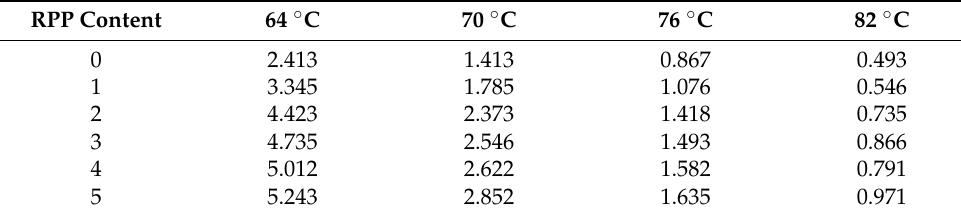
Table 5. Influence of temperature and RPP content on the G*/sin δ (kPa) of modified